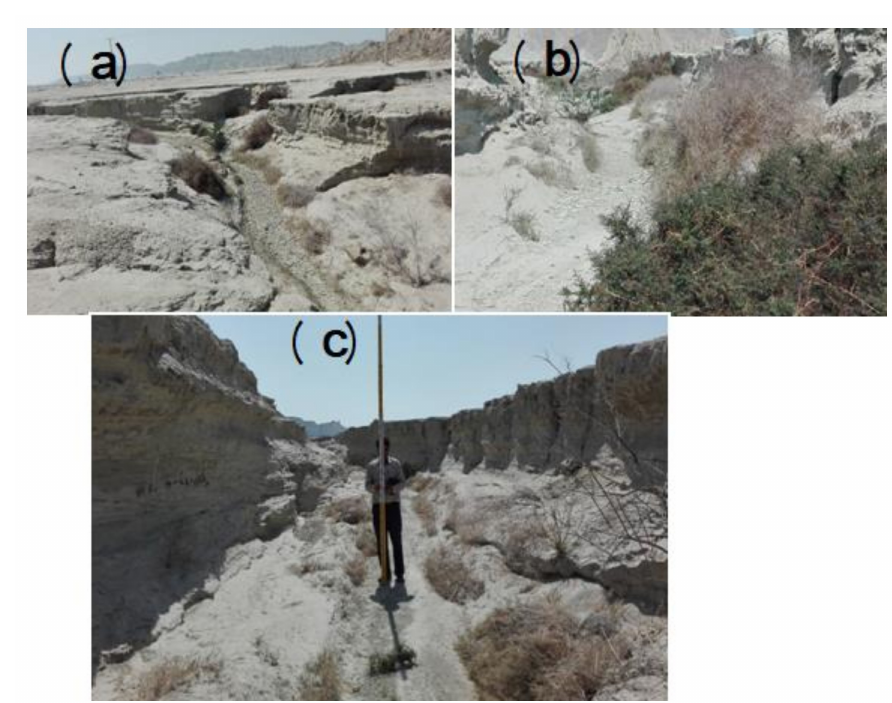
Figure 2. Images of gully erosion in Shirahan watershed: ( a ) head-cut gully; ( b ) gully erosion in salt land area; ( c ) measurement of gully morphometric